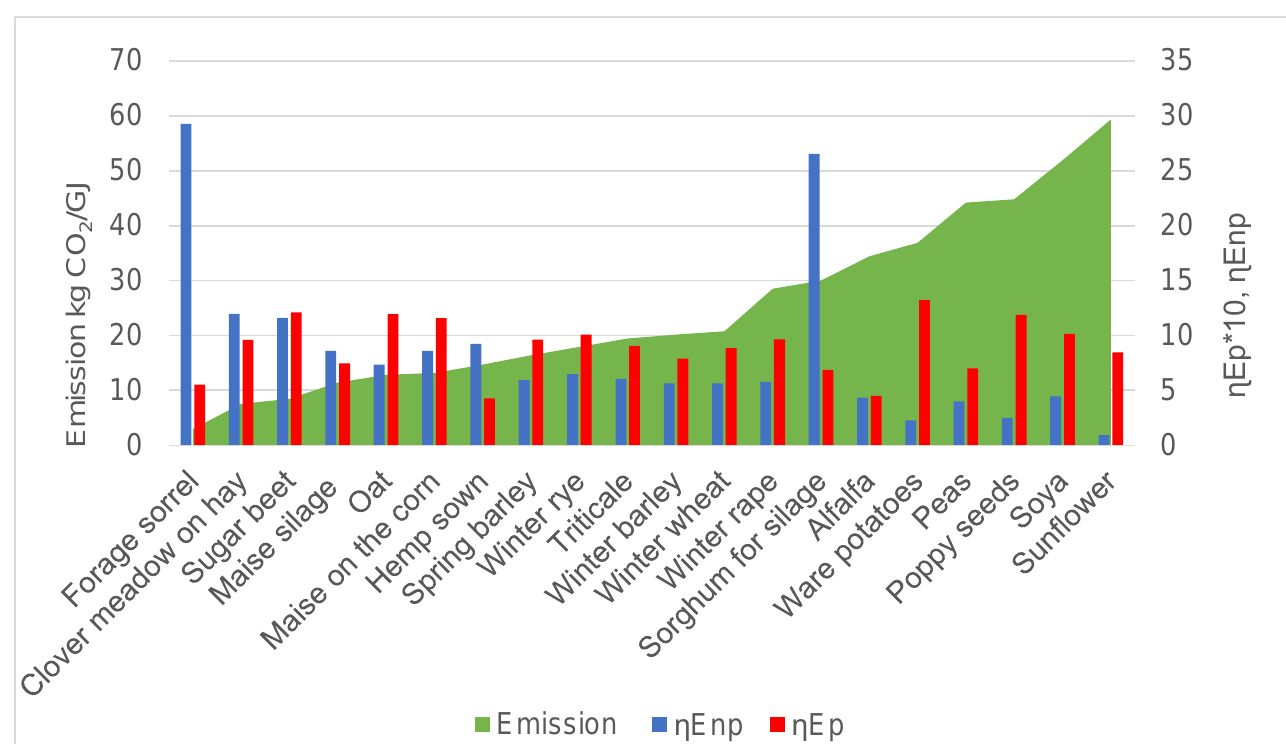
Figure 3. Average values of ηEnp, ηEp and CO 2 emission per GJ of energy in the product.